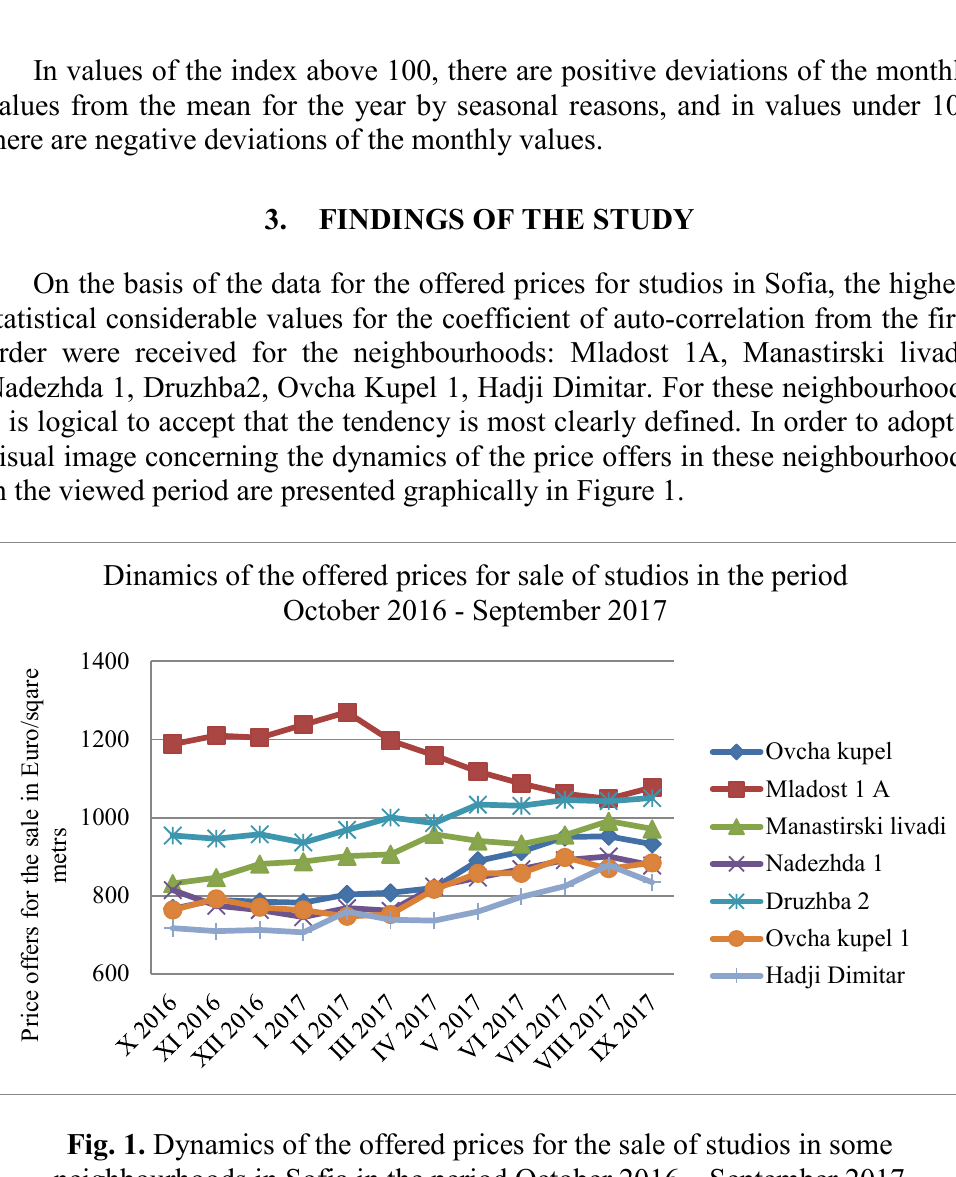
Fig. 1. Dynamics of the offered prices for the sale of studios in some neighbourhoods in Sofia in the period October 2016 – September 2017 (developed by the authors, using